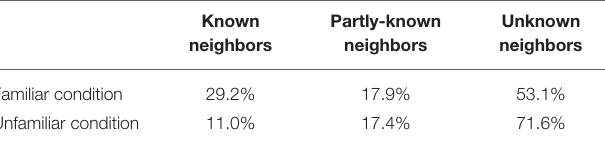
PercentagesreflecttheaverageproportionofTerminuswordswithKnown,Partly-Known, and Unknown Bridge word neighbors in the Familiar and Unfamiliar conditions. Each Terminus word’s (e.g., hajer) category was determined on a